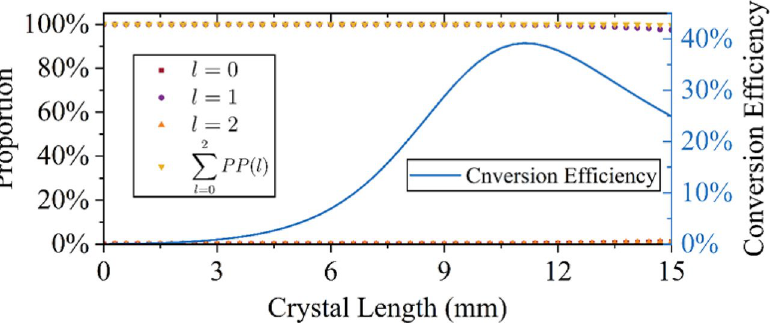
Figure 3. Change of OAM spectrum (left y-axis) and change of conversion efficiency (right y-axis) with crystal length.